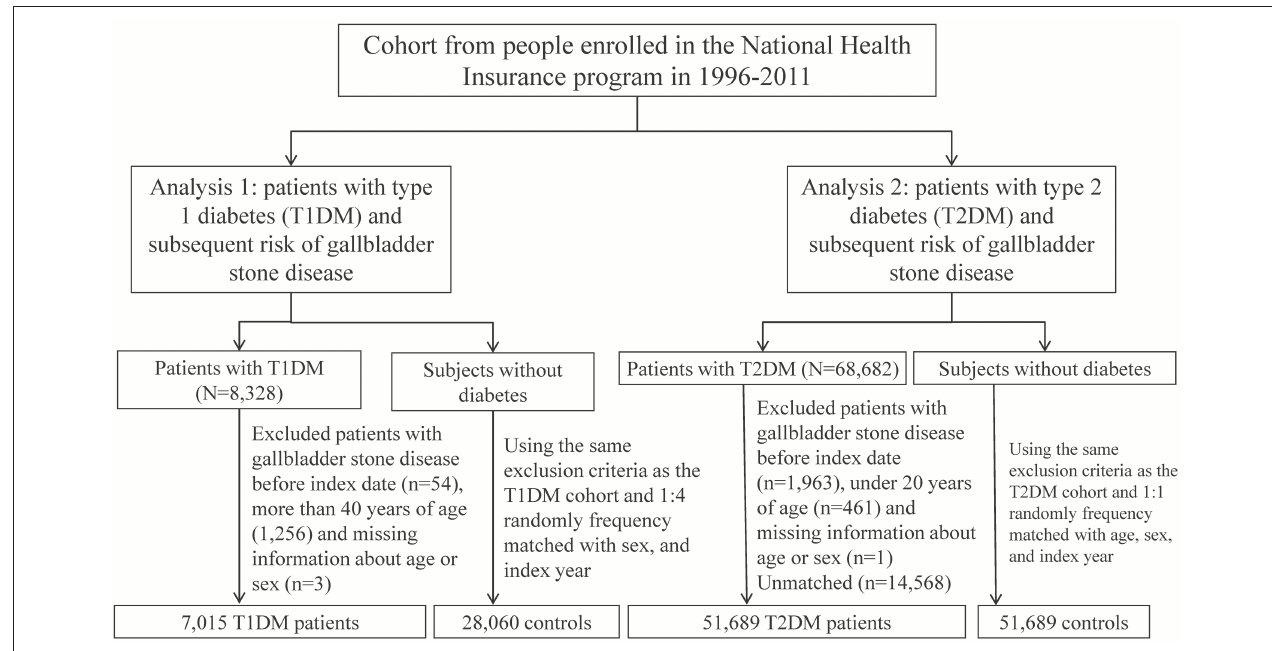
FIGURE 1 | The selection process of the two study cohort groups to evaluate the association of T1DM and T2DM with the development of